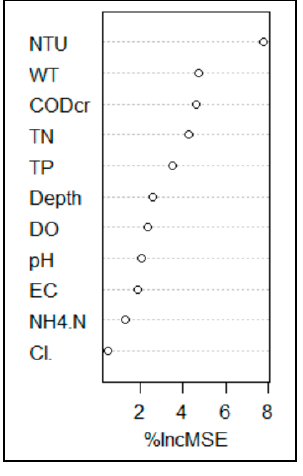
Figure 7. Effects of five environmental drivers (NTU, WT, COD cr , TN, and DO) on phytoplankton in spring. 3.5.2. Random Forest Analysis of Phytoplankton and Environmental Factors in Summer The 11 environmental factors explained 52.19% of total variance in summer, and the input feature importance ranking is shown in Figure 8a. Feature importance from the random forest cross-validation results (Figure 8b) showed Cl − (%IncMSE = 22.33), NTU (%IncMSE= 15.79), depth (%IncMSE = 6.090), WT(%IncMSE= 3.725), NH 4+ -N (%IncMSE =